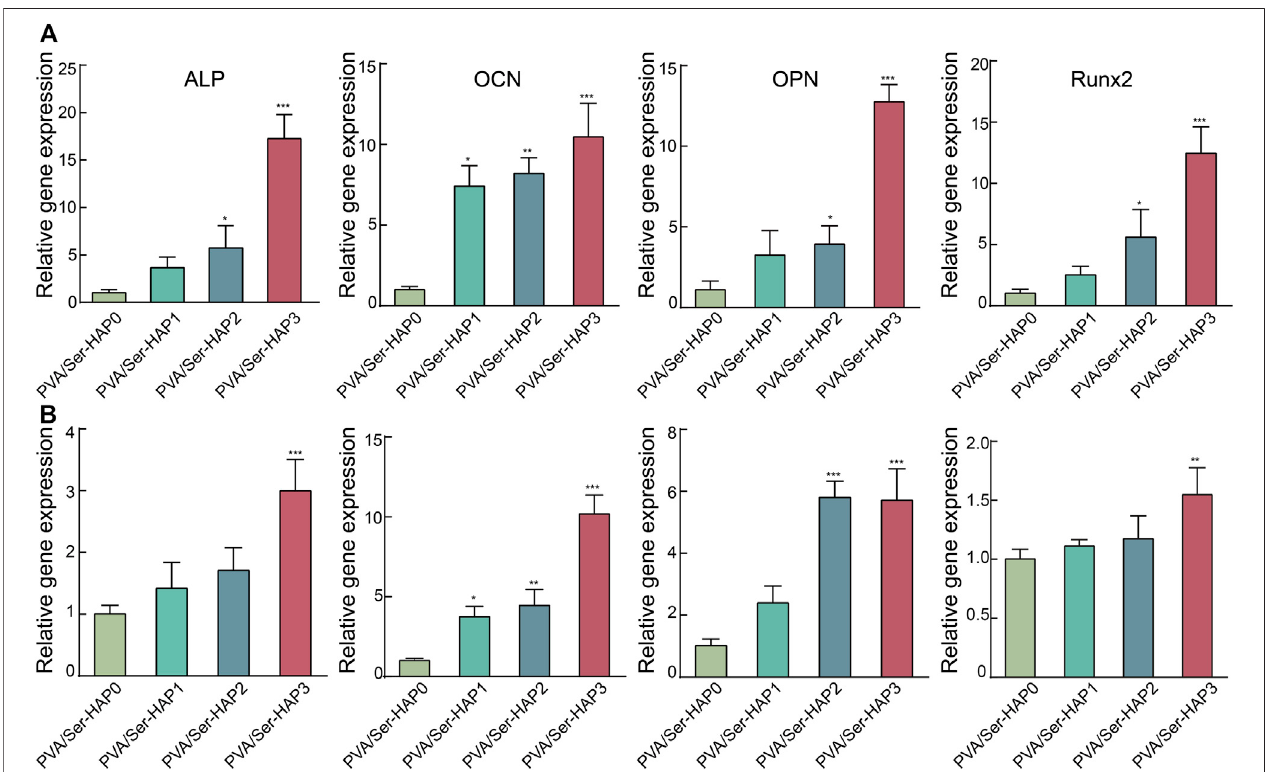
FIGURE 9 | RT-qPCR analysis of the ALP, OCN, OPN, and Runx2 expression of hPDLSCs following cultured by extracts of the PVA/Ser-HAP membranes for 3 days (A) and 5 days (B) .